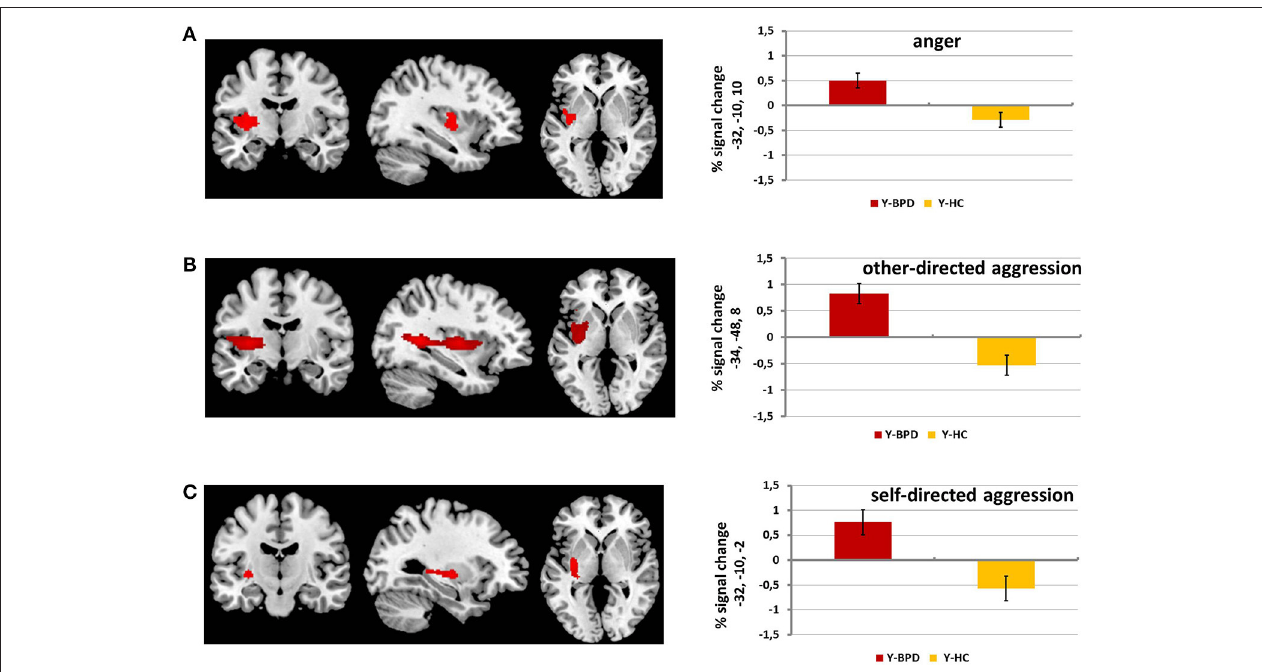
FIGURE 1 | fMRI results for anger, other-directed aggression and self-directed aggression phase. This figure displays whole brain results ( p < 0.001 and cluster size k ≥ 88) for the contrast adolescents with BPD (Y-BPD) vs. healthy adolescents (Y-HC) for anger phase vs. baseline phase (A) , other-directed aggression phase vs. baseline phase (B) and for self-directed aggression phase vs. baseline phase (C) .